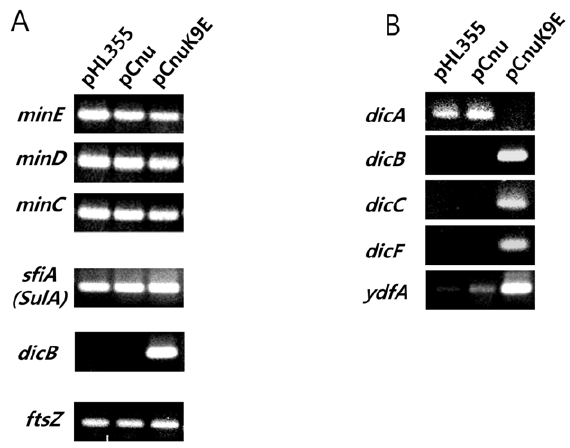
Figure 4. RT-PCR analysis of the expression of genes involved in cell division. Expression levels of genes involved in septal ring formation (A) and known to be repressed by dicA (B) were analyzed in MG1655 cells harboring pHL355 (vector control), pCnu (expressing WT Cnu), or pCnuK9E (expressing CnuK9E) at 37 u C.